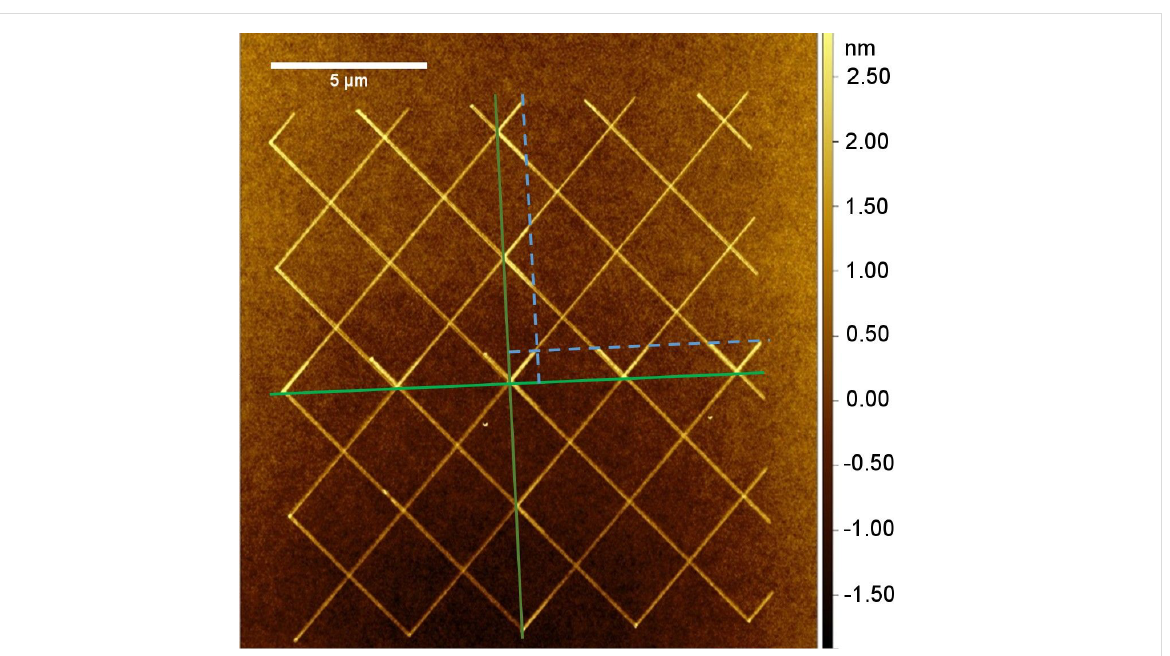
Figure 17: Example of stitching test showing an AFM image obtained directly after FE-eSPL exposure, showing negative tone features. The same pattern was written four times, indicated by the green lines, to compose the complete pattern. Stitching was achieved using scanner positioning. Before patterning the previously written features were measured with AFM and the new pattern was aligned to these structures, using an overlap of 0.5 µm with previous ones (indicated by the blue dashed